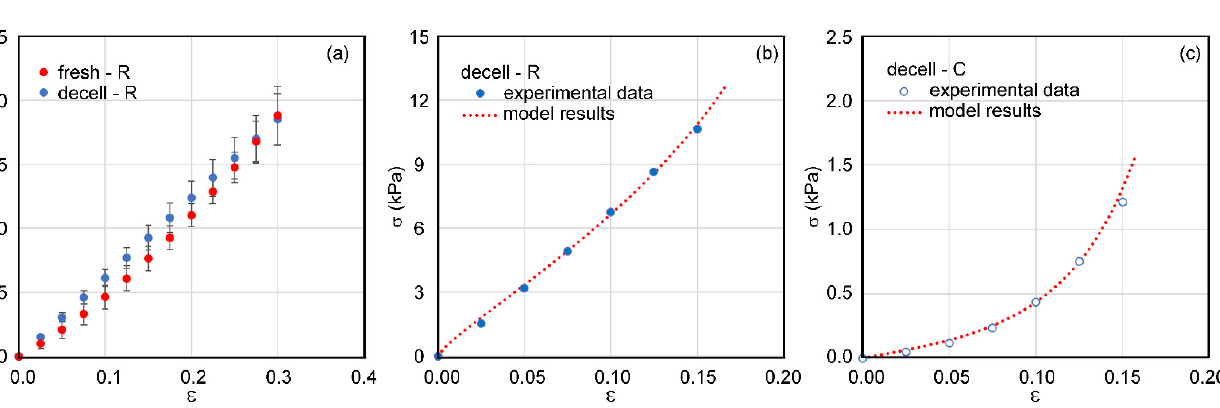
Figure 3. Stress–strain behavior of fresh and decellularized (decell) diaphragmatic tissue in radial (R) and circumferential (C) directions. Mean values of nominal stress P (with associated standard error of the mean) vs. strain ε of fresh and decellularized tissue in radial direction ( a ); comparison of experimental data and model results, in terms of Cauchy stress σ vs. strain ε , for decellularized tissue in radial ( b ) and circumferential ( c ) directions. Table 1. Secant elastic modulus E S (kPa) of diaphragmatic muscle tissue at 30% strain in radial (R) direction.